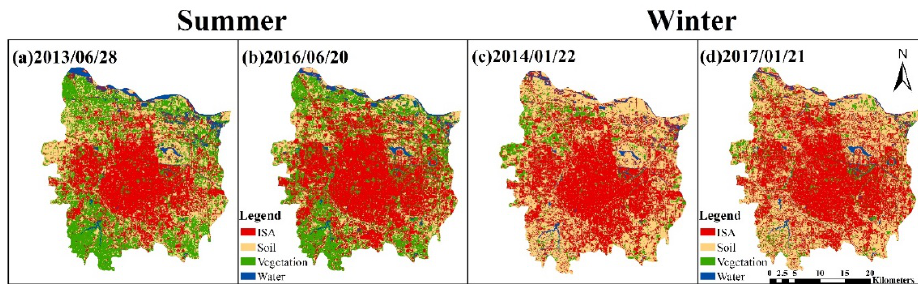
Figure 5. Spatial variations of LULC in Zhengzhou on four dates.